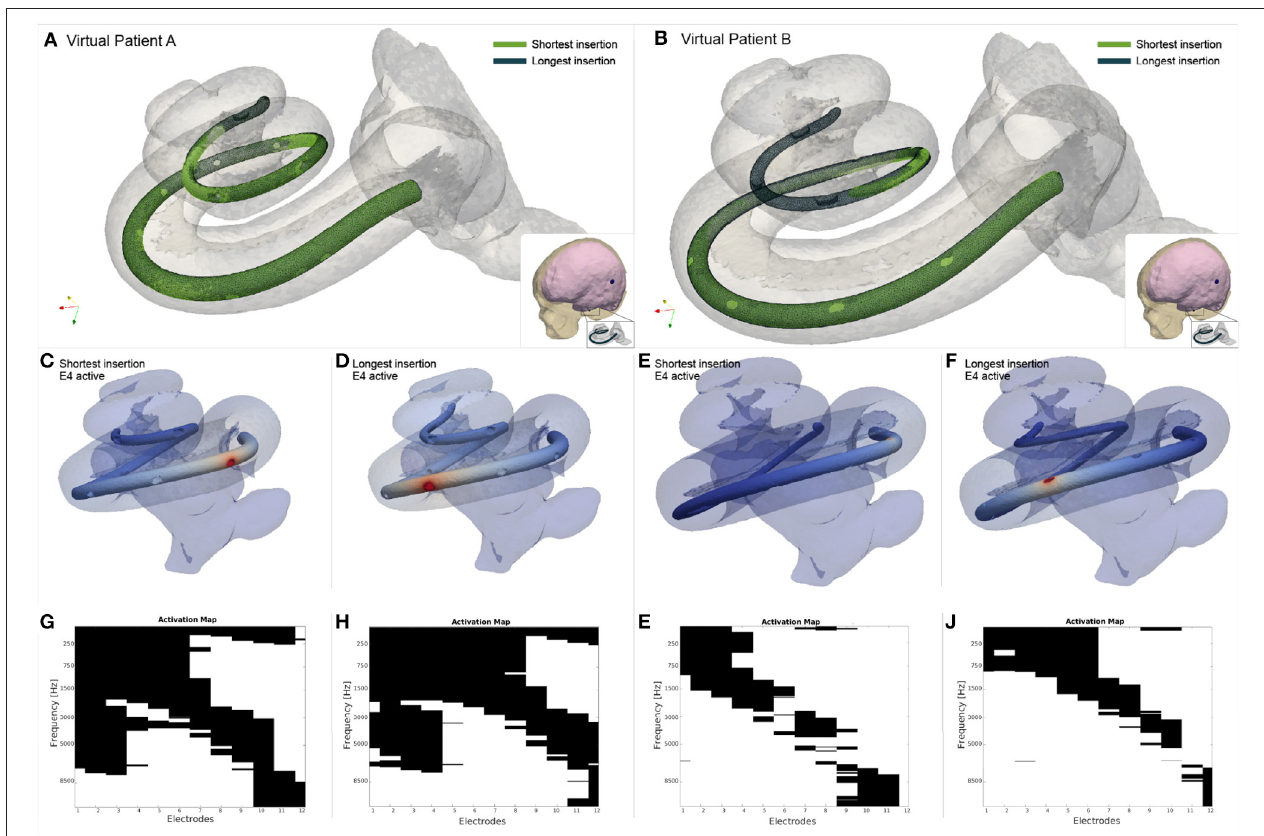
FIGURE 3 | Example of two virtual patients with different cochlear sizes, both with the shortest and longest EA insertion depth allowed by the model morphology. (A,B) 3D model of the cochlea. (C–F) Potential created by the fourth electrode (E4) on the EA. (G–J) Evoked neural response on all ANF when each electrode delivers the